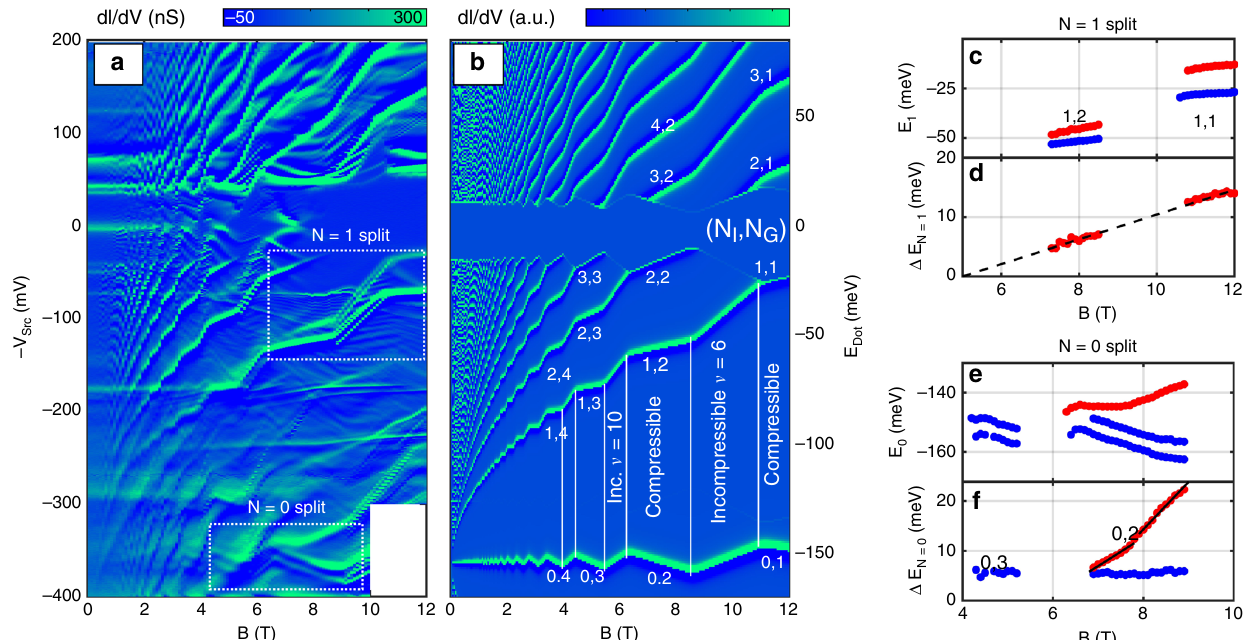
Fig. 3 Spectrum at fi xed density. a d I /d V vs. − V Src and B , graphene density fi xed at n Gr = 3.1×10 12 cm − 2 . Dashed regions mark N = 0 and N = 1 spectral features which show evidence of degeneracy lifting. b Simulation modelling the data at a . μ Dot = 95meV, d Dot = 0.85nm. Spectral features are marked by index pair: Injection/ejection level N I and ground state N G . Compressible and incompressible regimes are marked at the negative bias. c Energies of the split peaks of the N = 1 feature. d Energy difference of the features in c . Dashed line corresponds to g = 36. e Energies of the split peaks of the N = 0 feature. f Energy difference of the peaks in e . Blue: Valley split. Red: Spin split. Overlay lines trace two different slopes, corresponding to g = 100 and g = 160,